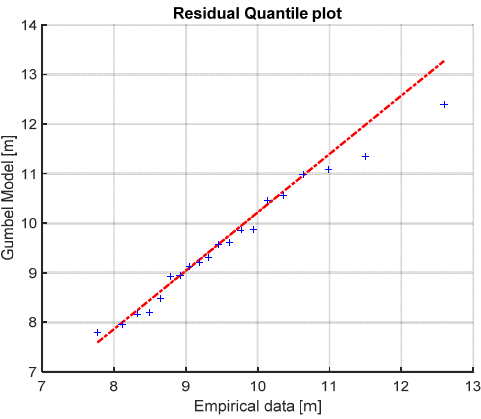
Figure 23. Residual quantile plot for maximum tension values, Case 1, Minimum Diameter. Next, the most probable maximum extreme (MPME) value of tension and horizontal motion of the system is calculated based on Equation (8) and compared with the quasi- static analysis results in Tables 19–21. In order to consider the worst scenario, the loads are assumed to act collinearly in the direction of one cable. The results of the most proba- ble extreme tensions, calculated with the 3-h coupled analysis (Table 19), show, as ex- pected, higher tensions in the cable parallel to the direction of the environmental forces. More in particular, the up-loads line, presents tensions between 7 to 20% higher than the other two cables, which display a symmetrical behaviour. Table 19. MPME tension values calculated on each fairlead. Case 355.6 Table 20. Difference of maximum line’s tension between quasi-static and couple analysis. Case 20 Table 21. Difference of maximum horizontal excursion between quasi-static and couple. Case